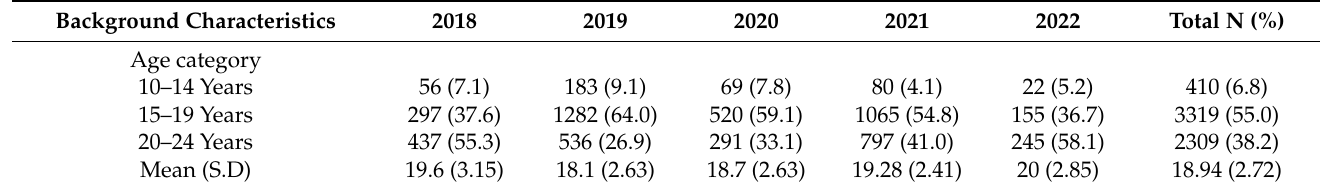
Table 1. Socio-demographic characteristics of the beneficiaries ( n =